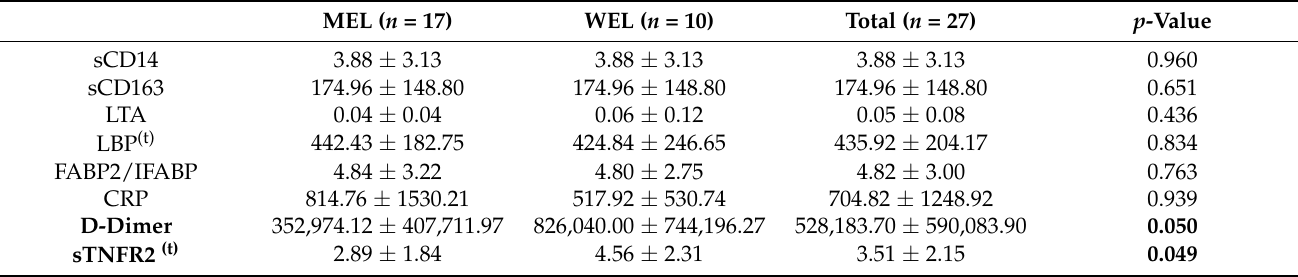
Table A6. Inflammatory biomarkers (ng/mL) by dietary patterns.